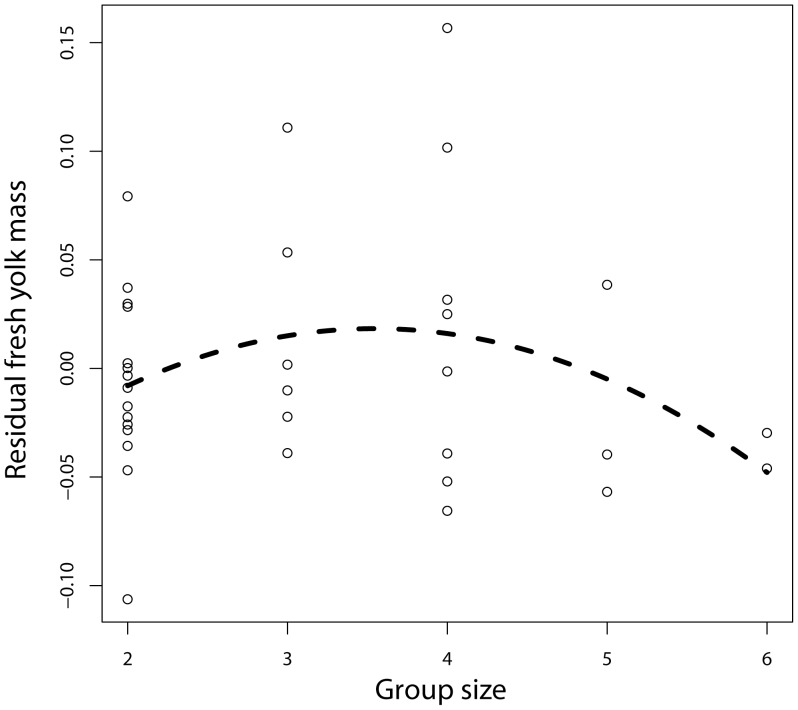
Relationship between fresh yolk mass of first laid eggs (corrected for egg mass) and breeding group size.Dashed line indicates predicted values from the linear mixed-effects model.